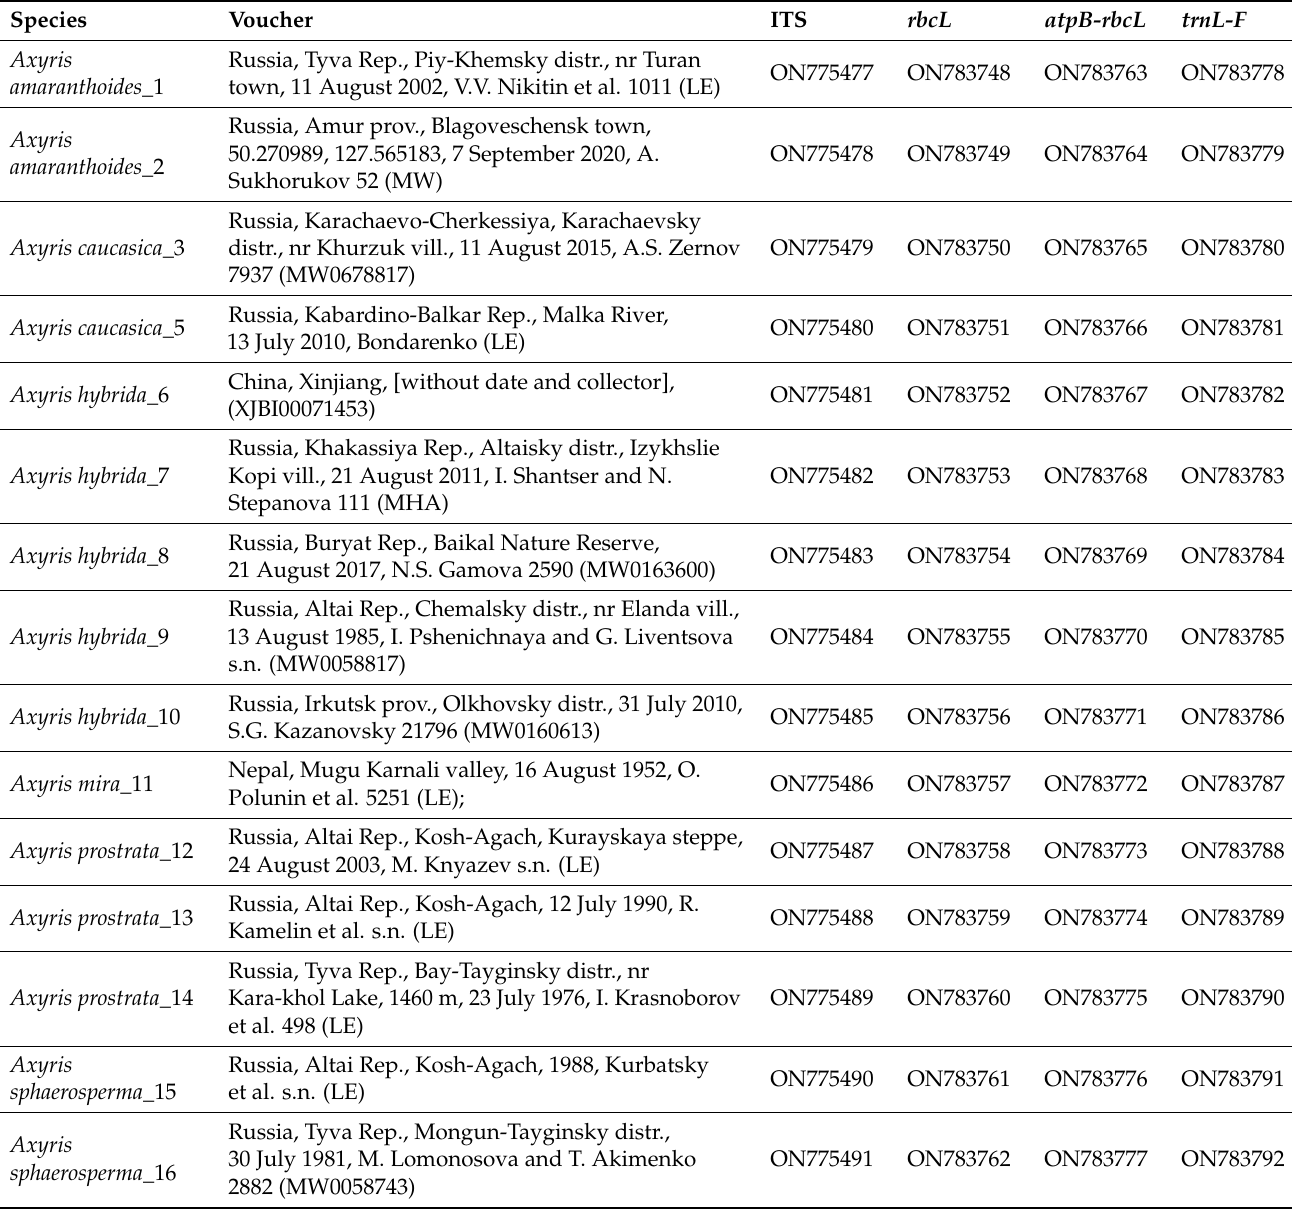
Table 1. Voucher information and GenBank accession numbers for the species of Axyris and outgroups included in the phylogenetic